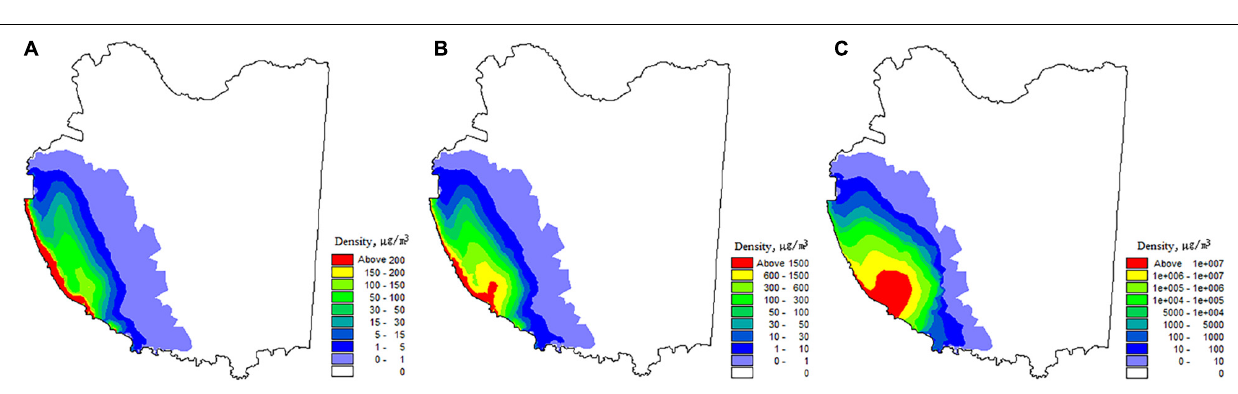
FIGURE 13 | The density profile of alien phytoplankton under different conditions in Huanghua port. (A) Condition 1. (B) Condition 2. (C) Condition